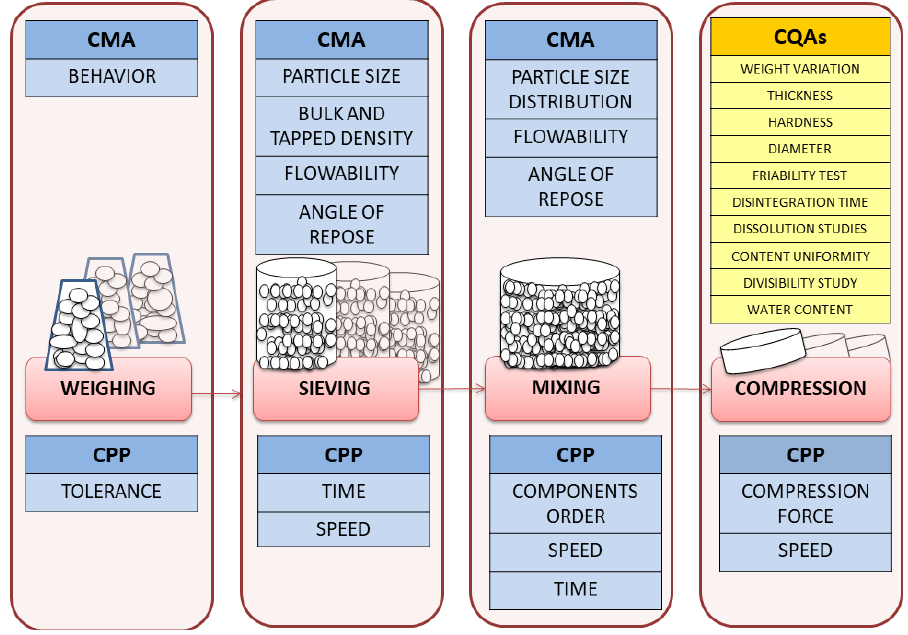
Figure 6. Aspects of the manufacturing process: critical material attributes (CMA), critical process parameters (CPP), product quality attributes (CQAs). parameters (CPP), product quality attributes